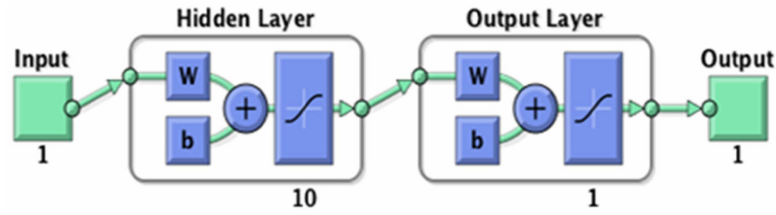
Figure 1. The ANN classifier for the LOL estimation for model